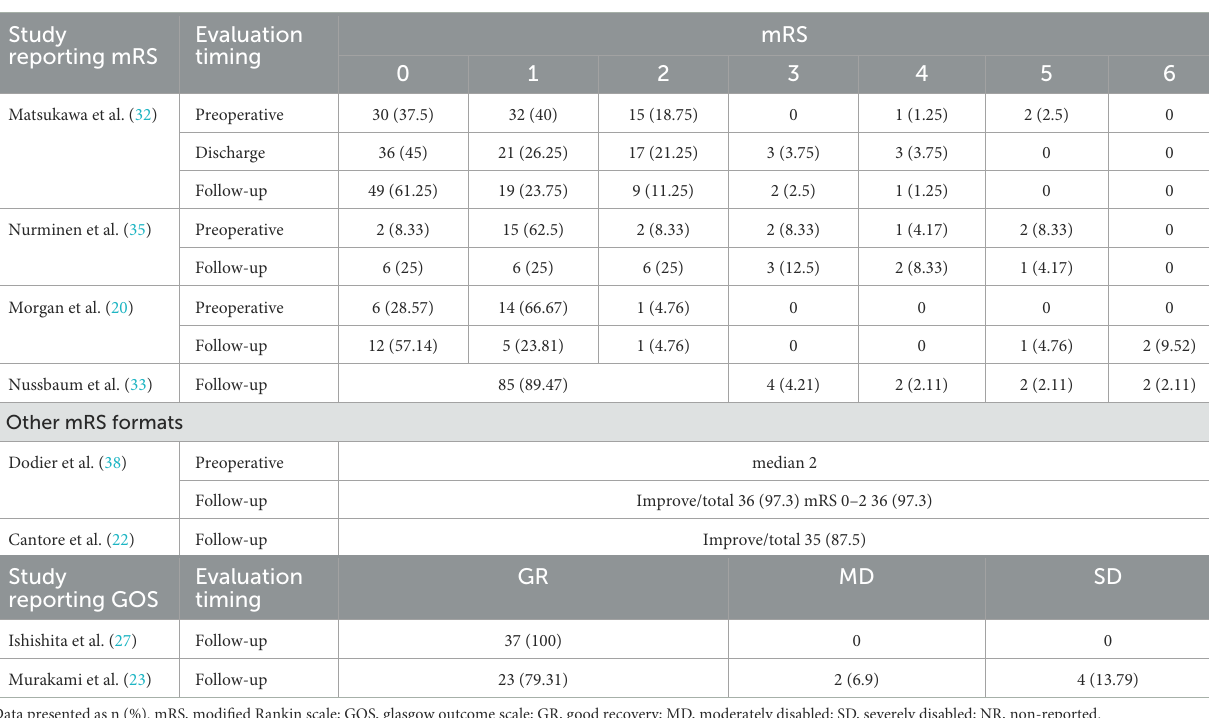
TABLE 4 Neurological function score of included studies.